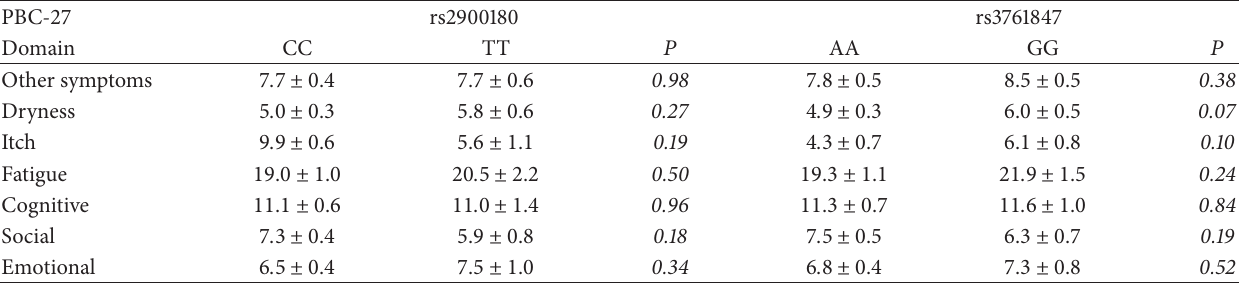
Table 4: Relationship between rs2900180 and rs3761847 TRAF1-C5 polymorphisms and PBC-27 questionnaire.